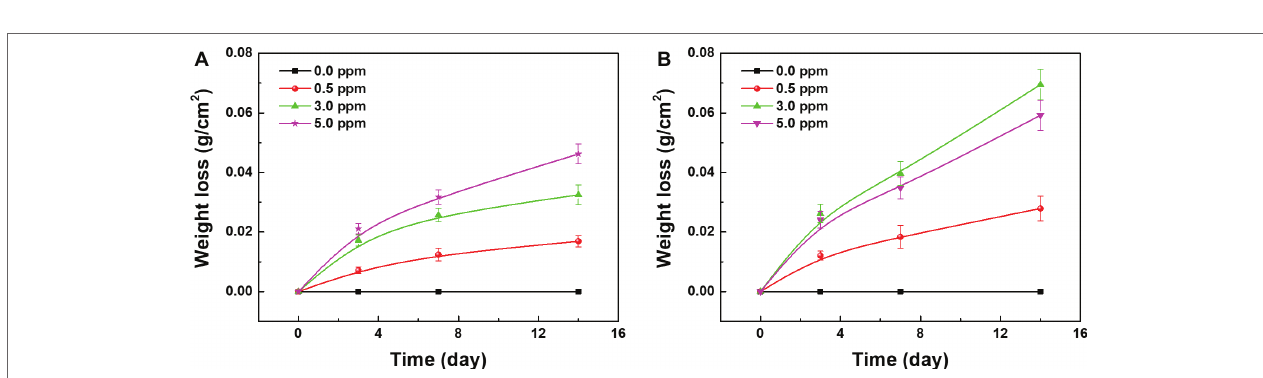
FIGURE 6 | CLSM images and maximum pit depths of the samples after 14 days of immersion in (A) 0.5 ppm and (B) 3.0 ppm inoculated